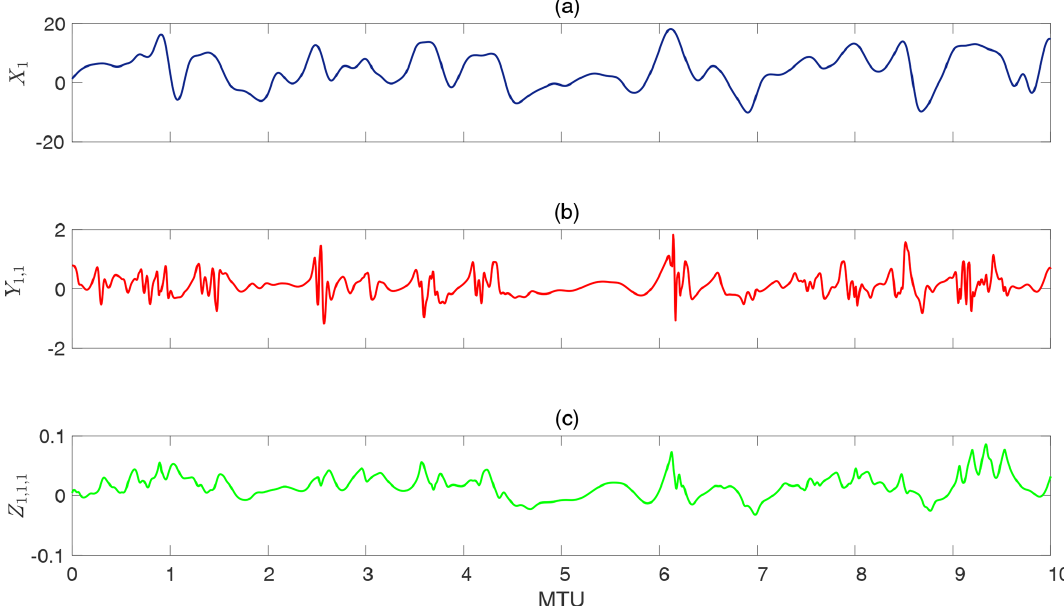
Figure 1. Time evolution of (a) X k at grid point k = 1, (b) Y j, 1 at grid point j = 1, and (c) Z i, 1 , 1 at grid point i = 1. The time series show chaotic behavior in X , which has large amplitude and slow variability; Y , which has relatively small amplitudes, high-frequency variability, and intermittency; and Z , which has small amplitudes and high-frequency variability. The x axis is in model time units (MTUs), which are related to the time step of the numerical solver ((cid:49)t) and largest positive Lyapunov exponent (λ max ) as 1MTU = 200 (cid:49)t ≈ 4 . 5 /λ max (see Sect. 2.1). Note that here we are presenting raw data which have not been standardized for predictions or testing yet.